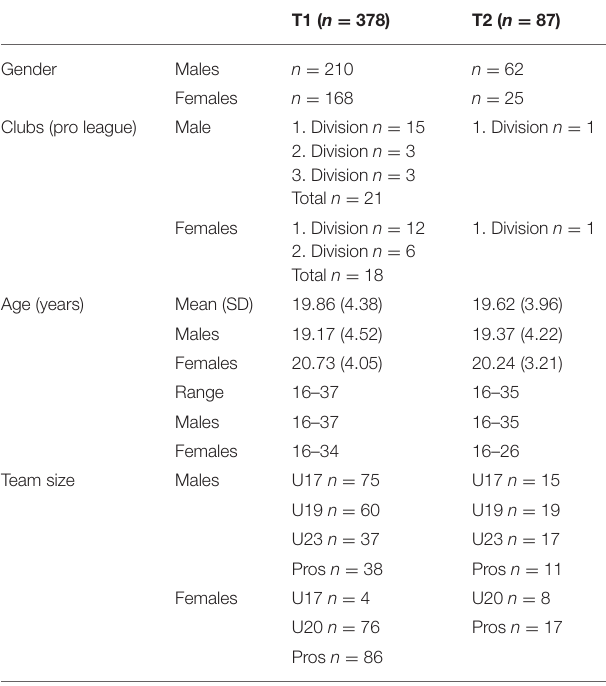
Participants’ information for T1 and T2. T1 represent the first measurement, T2 represent the second measurement 6 weeks post